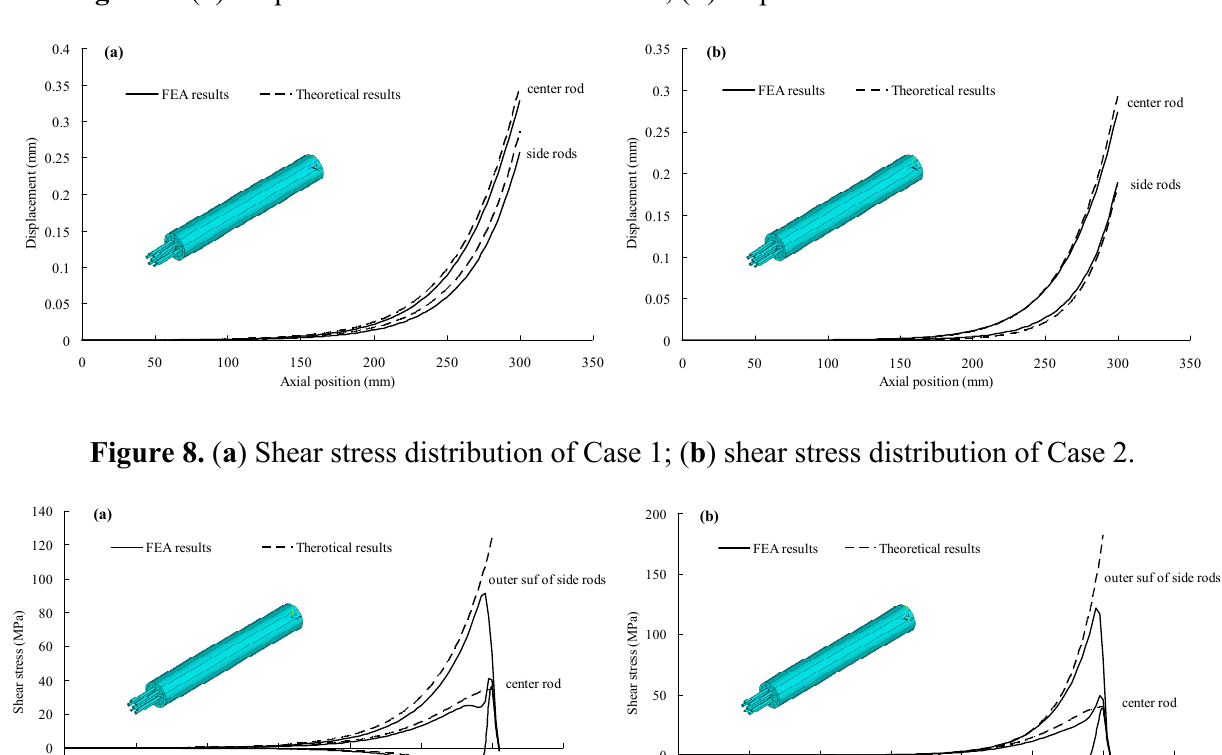
Figure 7. ( a ) Displacement distribution of Case 1; ( b ) displacement distribution of Case 2.